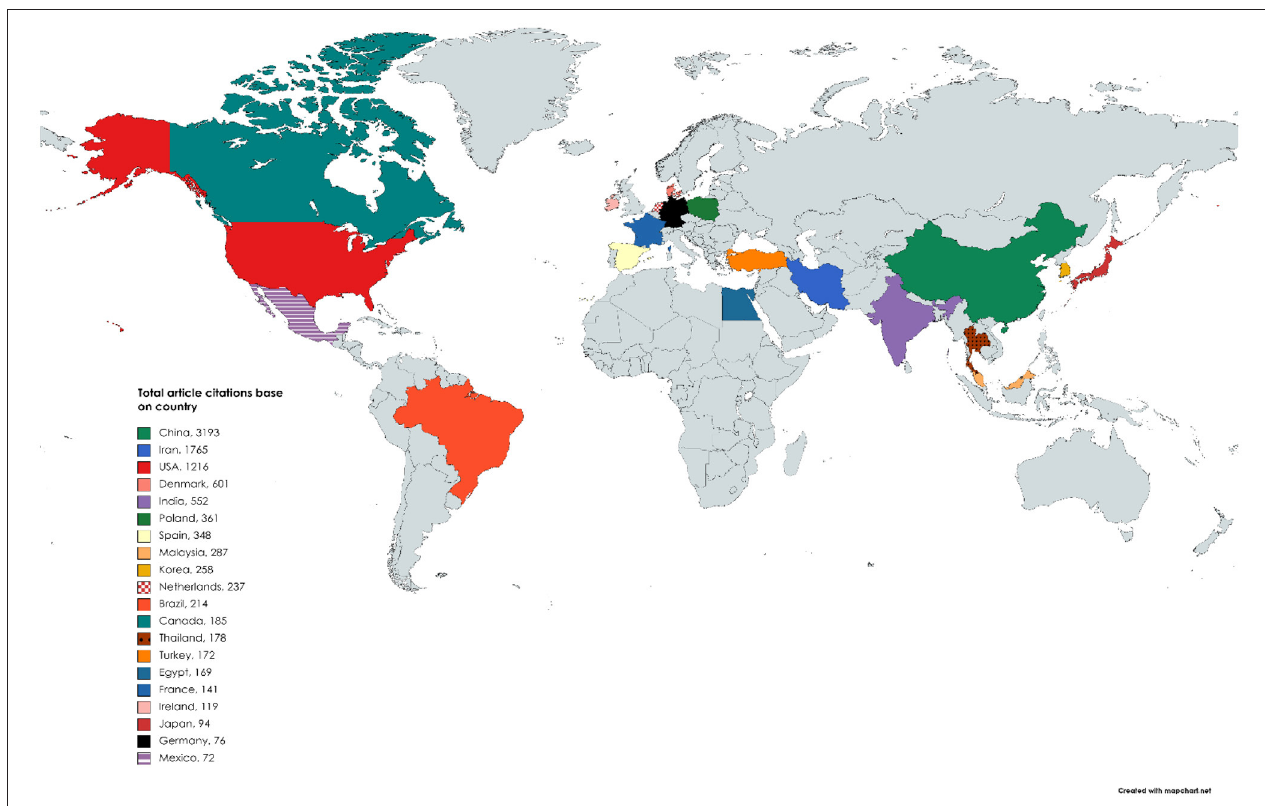
FIGURE 2 | Spatial distribution of top 20 total citations by different countries. Gray color covering depicts the areas that are not part of the top 20 total citations.